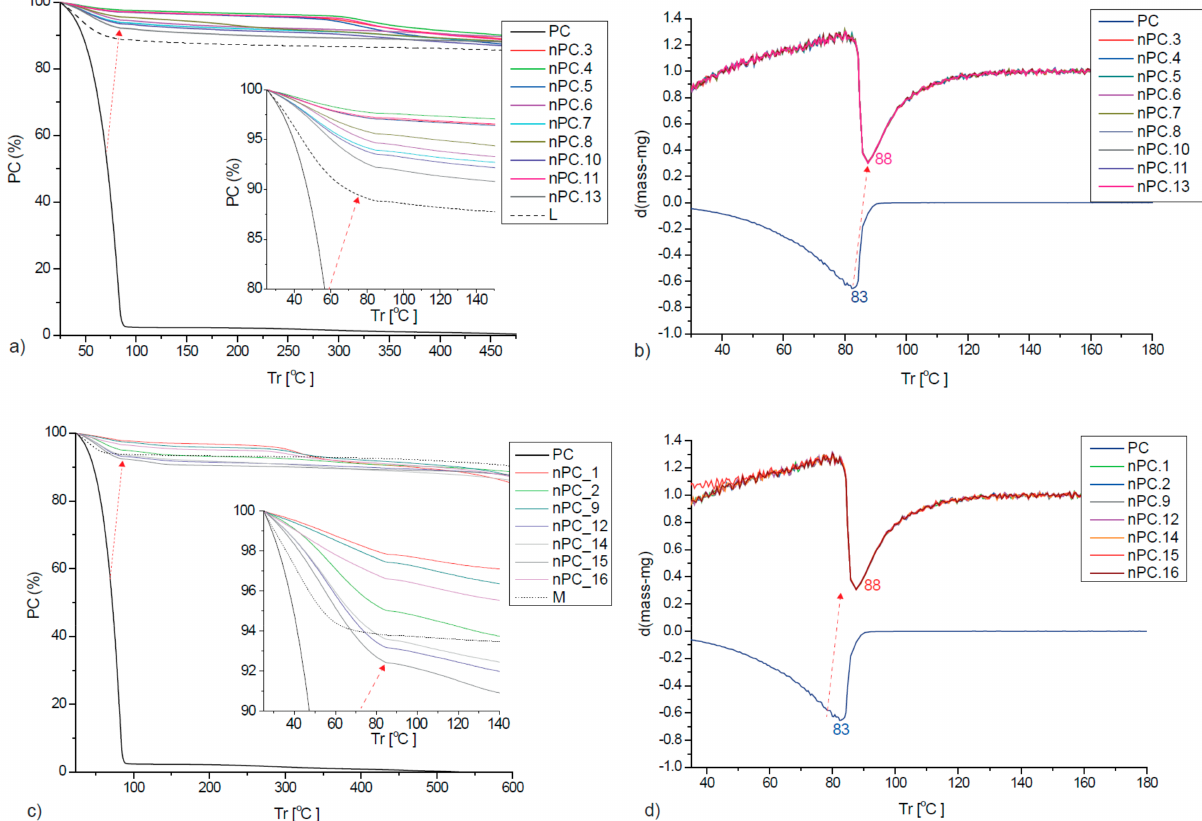
Figure 11. ( a ) TGA and ( b ) DTA diagram of laponite (L), PC original pigment and the synthesized hybrid pigments under different conditions [1–16]. ( c ) TGA and ( d ) DTA diagrams of laponite (L), PC original pigment and the synthesized hybrid pigments under different conditions